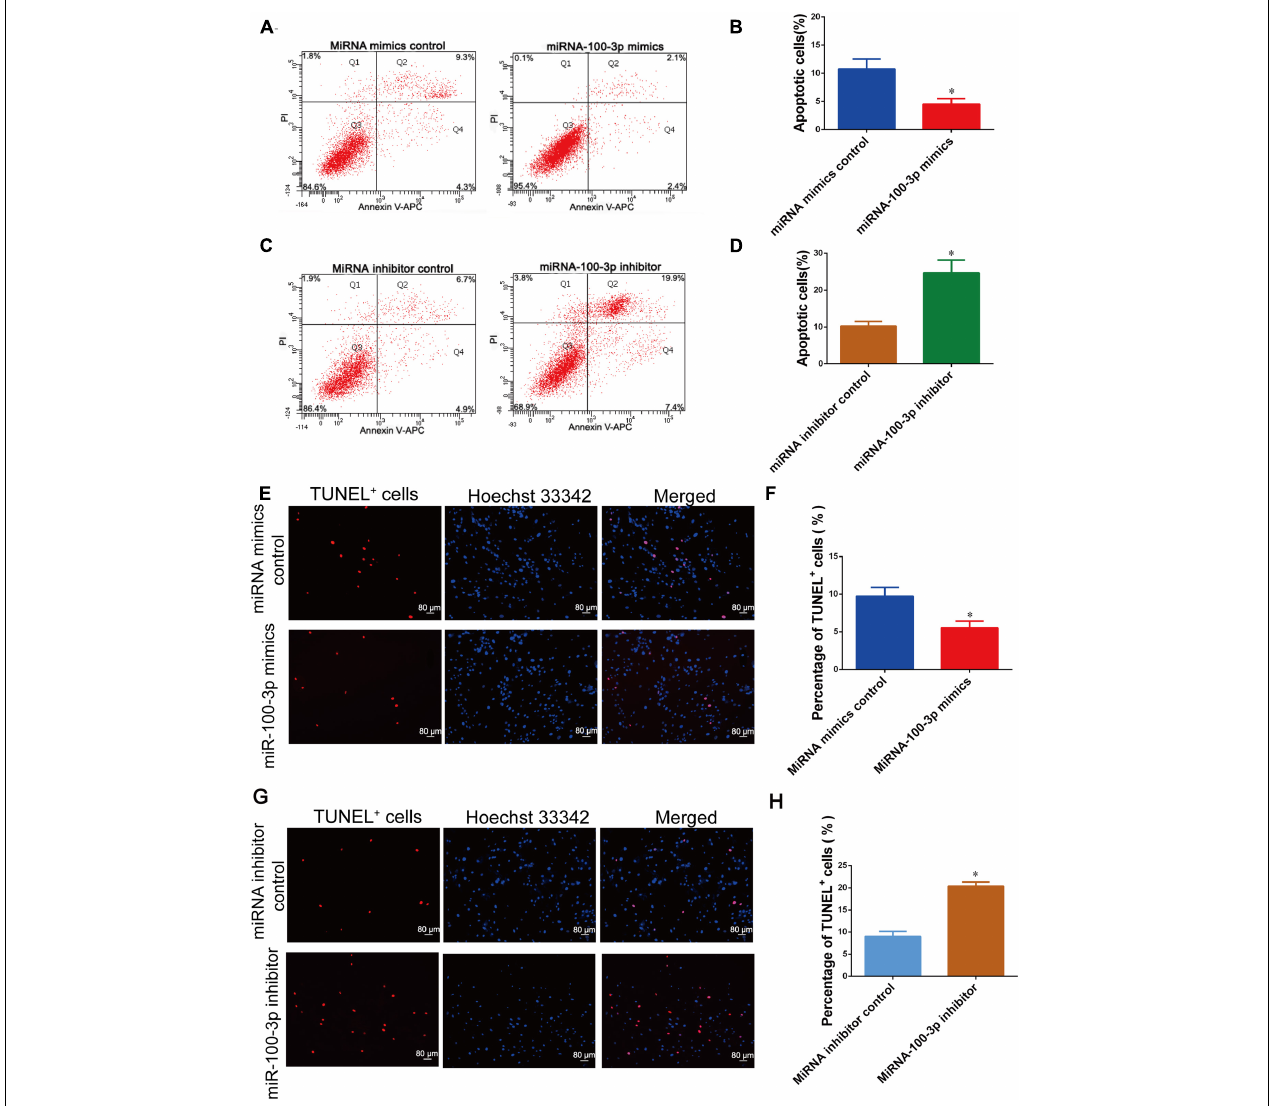
FIGURE 4 | MiR-100-3p inhibits human Sertoli cell apoptosis. (A–D) The percentages of human Sertoli cell early and late apoptosis affected by miR-100-3p mimics (A,B) and miR-100-3p inhibitor (C,D) by comparison to the respective control. (E–H) The ratios of terminal deoxynucleotidyl transferase dUTP nick end labeling (TUNEL)-positive cells in human Sertoli cells treated with miR-100-3p mimics and miR-100-3p inhibitor by comparison to the respective control. Scale bar in panels (E,G) = 80 µ m. * denoted the statistical difference between miR-100-3p mimics and miRNA mimics control or miR-100-3p inhibitor and miRNA inhibitor control.